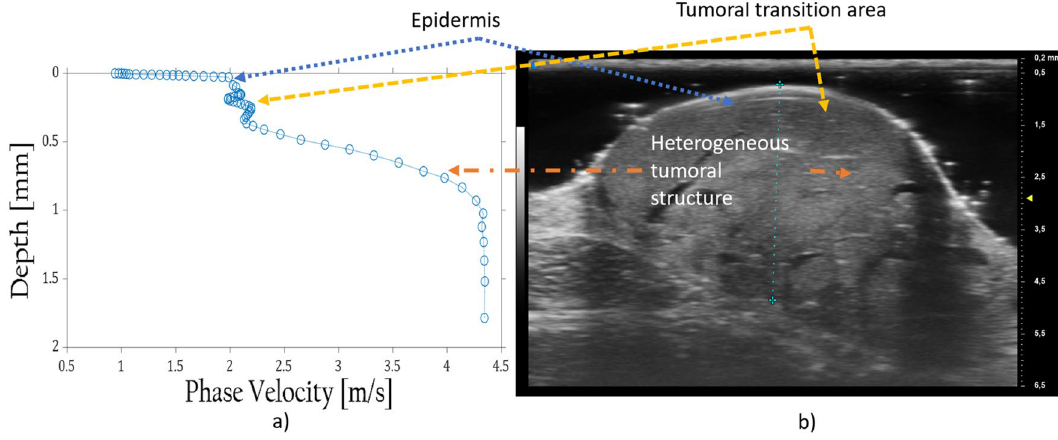
Figure 2. Cross correlation between Angioma velocity profile ( a ) and mode-B image ( b